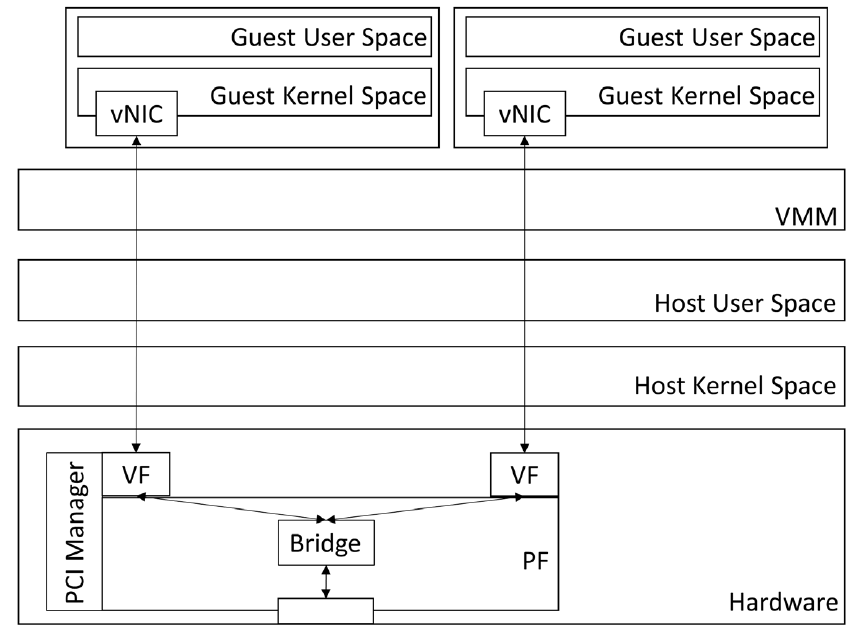
Figure 4. Network architecture of SR-IOV.